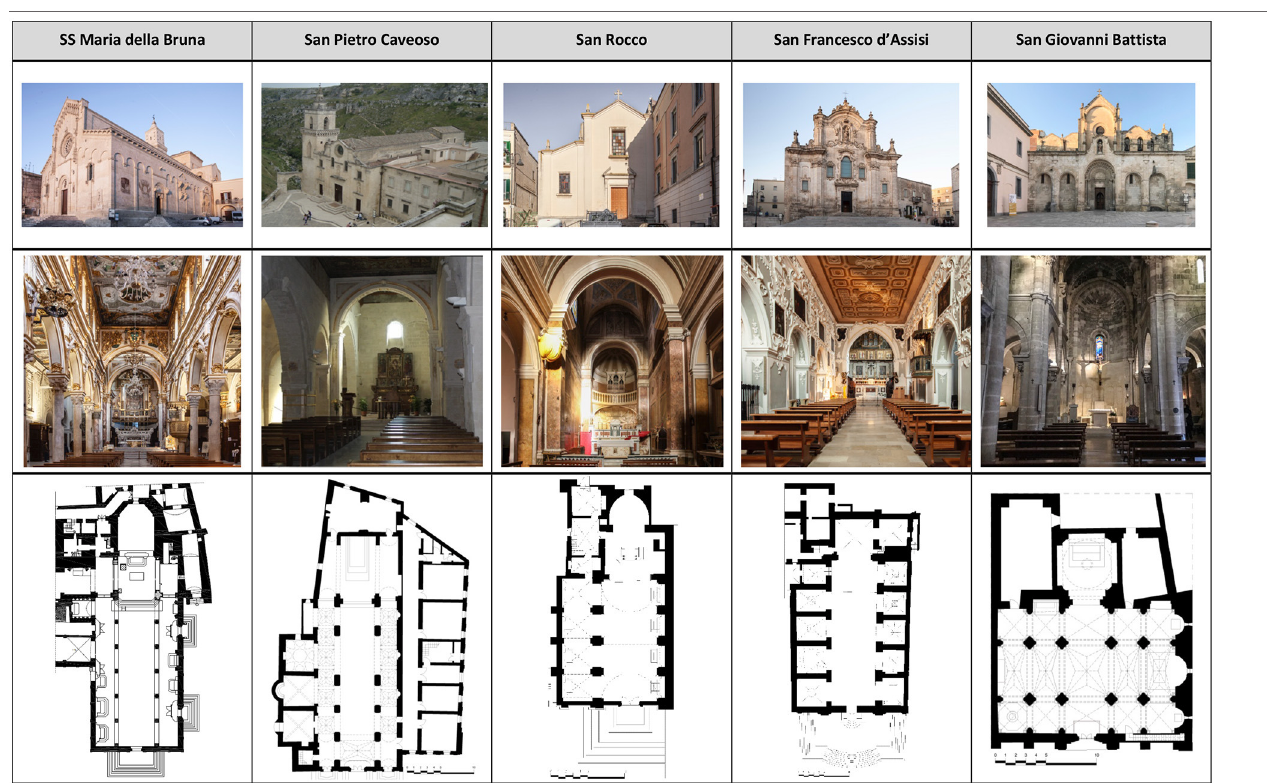
TABLE 1 | Some views of the considered case